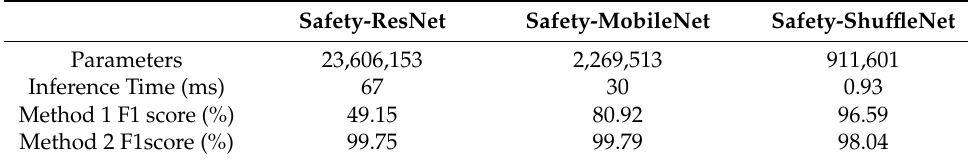
Table 2. Comparison of performance according to training methods by